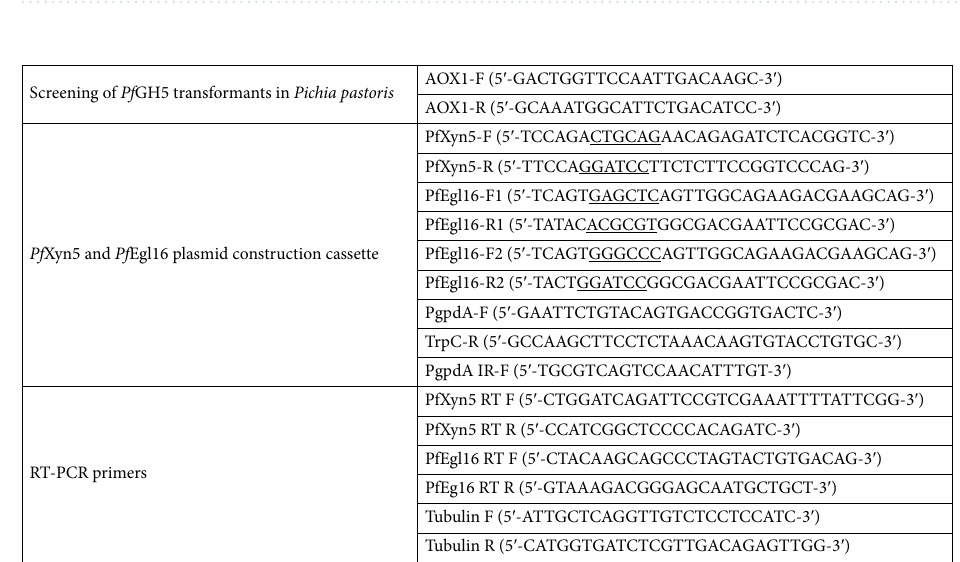
Table 4. List of plasmids and strains used in the study.